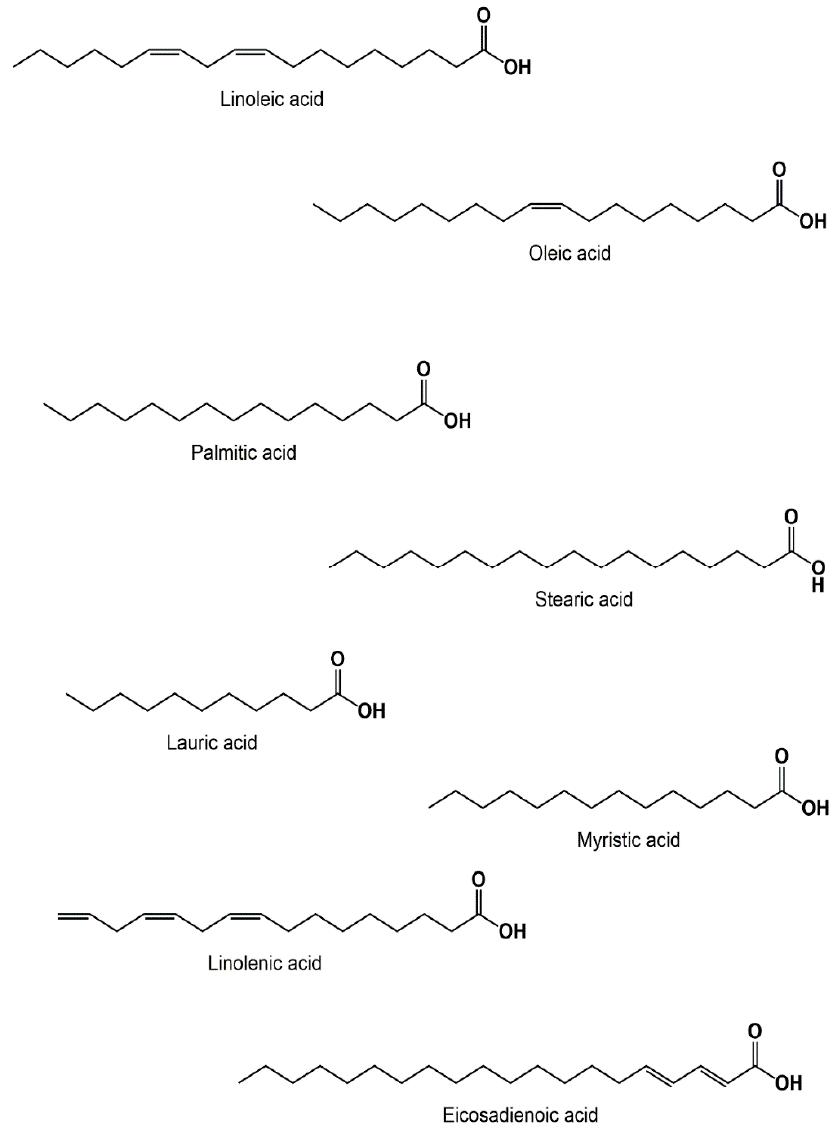
Figure 5. Examples of fatty acids found in NS seeds.